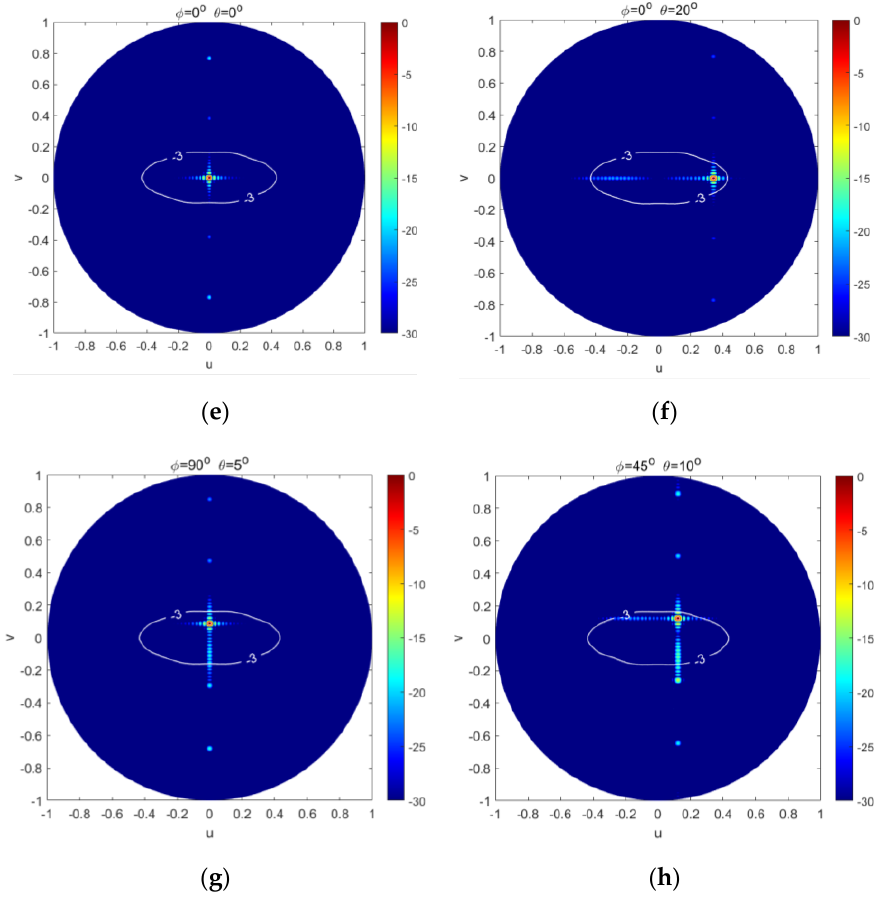
Figure 13. Array factor ( a – d ) and the radiation pattern ( e – h ) of the 65 × 19 array for various scan angles, where u = sin θ cos φ and v = sin θ sin φ . The −3 dB contour of the central sub-array radiation pattern of the 11 × 5 array is also shown.